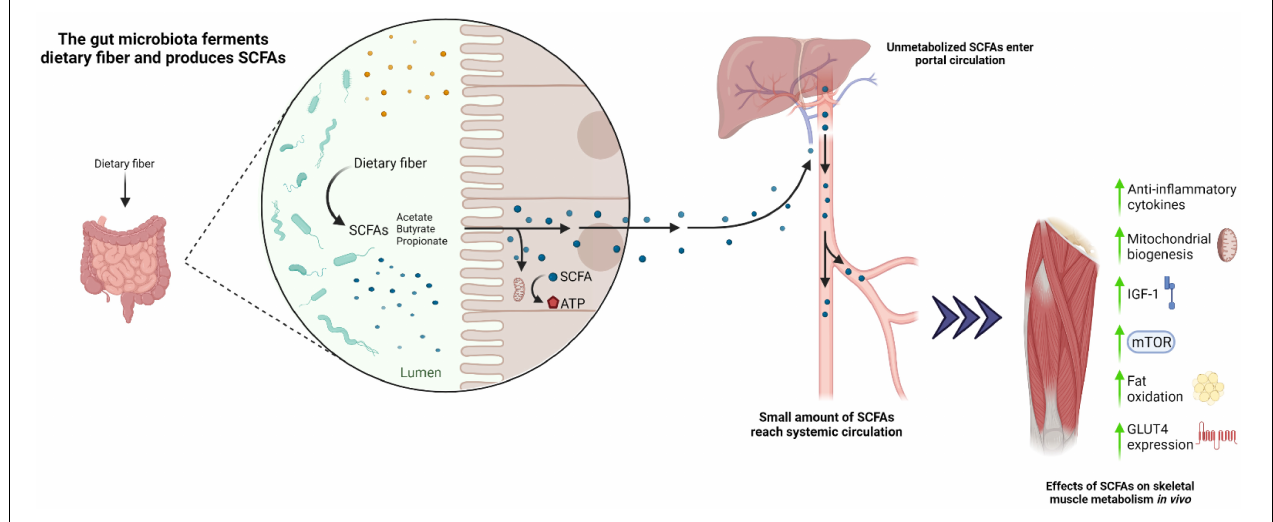
FIGURE 2 | Proposed role of the gut microbiota in modulating skeletal muscle metabolism under conditions of increased dietary